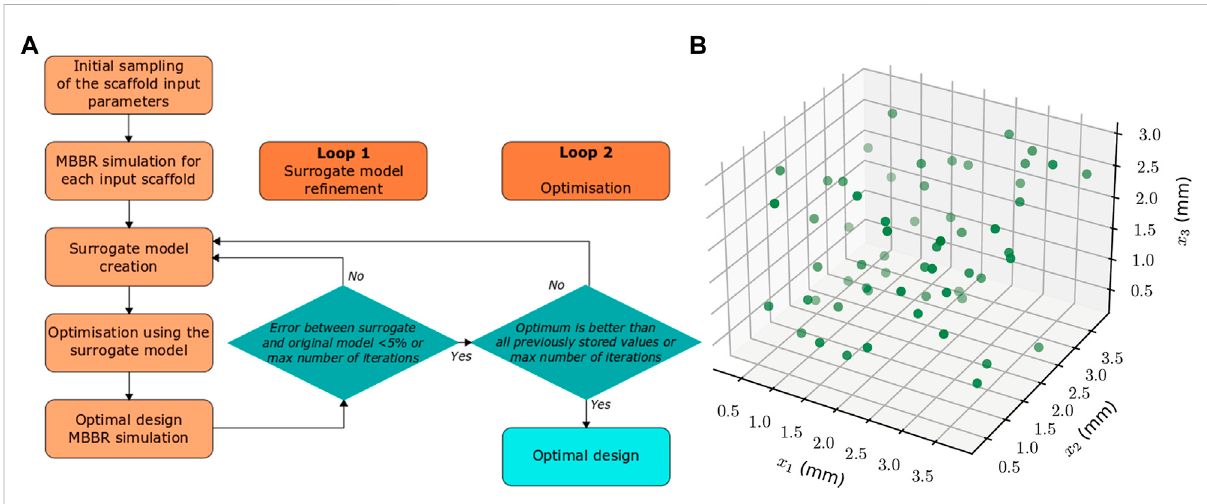
FIGURE 2 (A) Flow chart of the scaffold design optimization computational framework for enhanced bone regeneration. (B) Locations of the initial samples (in the space de fi ned by the three parameters x 1 , x 2 , x 3 ) for which the MBBR model is run to compute the surrogate